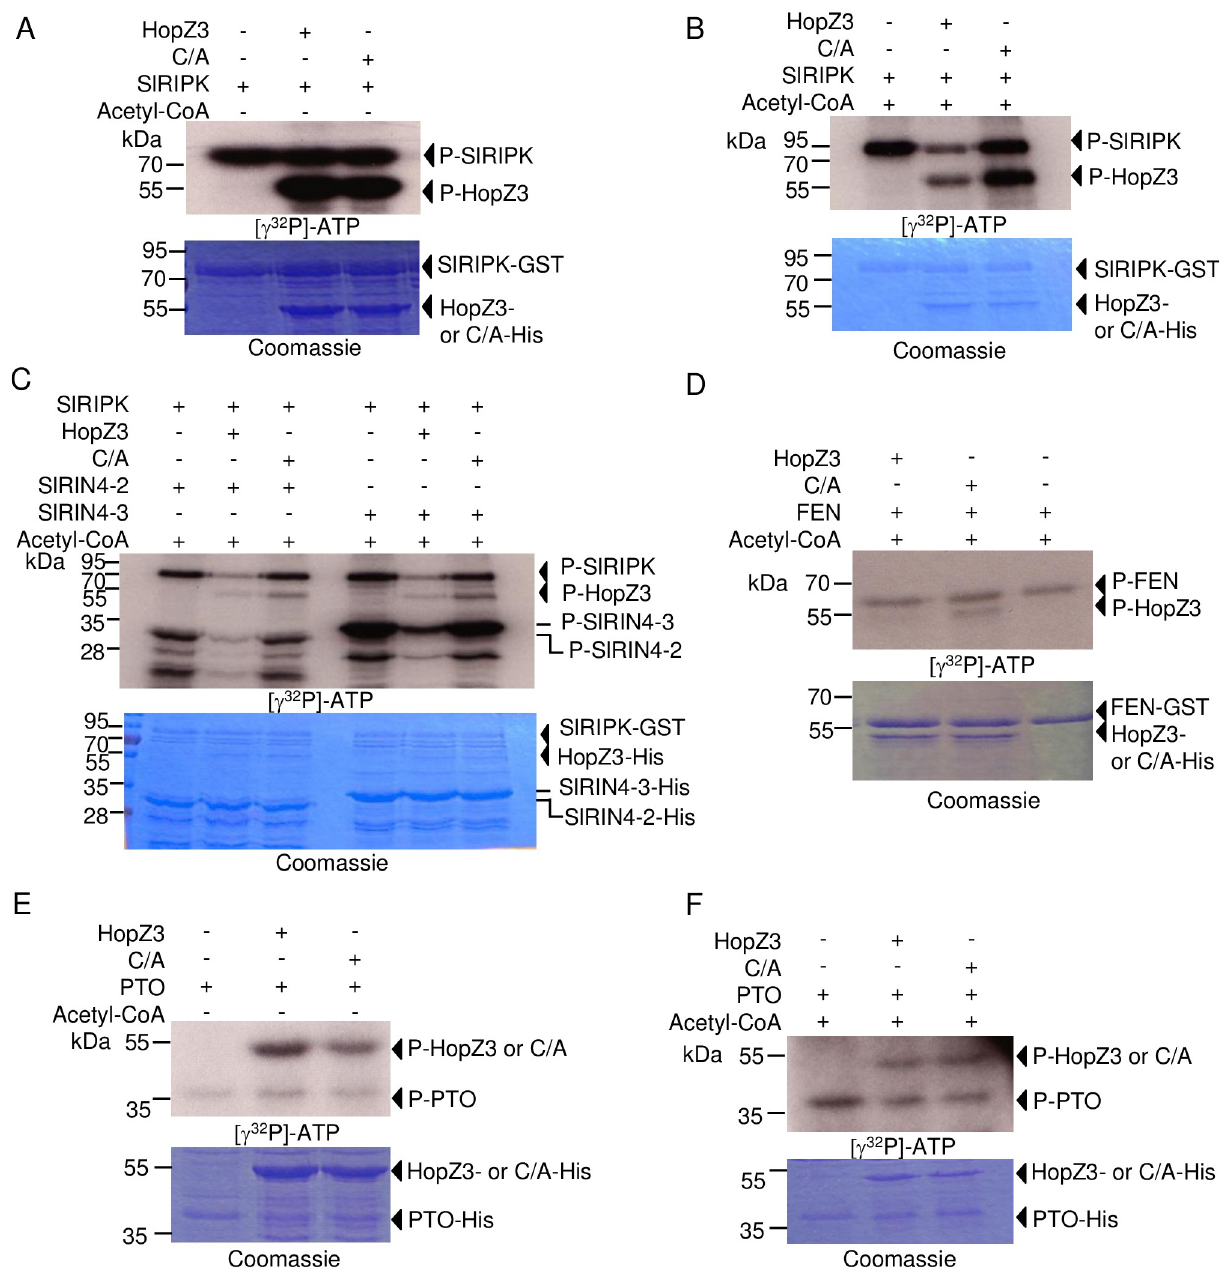
Fig 8. Differential effects of HopZ3 acetylation on kinase activity of RIPK, PTO and FEN. GST fusions of SlRIPK (A–C) and FEN (D) or PTO-His (E–F) were incubated with or without acetyl-CoA, IP6 and HopZ3 or HopZ3_C300A (C/A) for 2 h at RT and then washed with PBS buffer. After acetylation, the kinase activity of SlRIPK, FEN or PTO was initiated by adding γ 32 P-ATP and MgSO 4 for 30 min. at RT. (A) Incubation of SlRIPK with HopZ3 in the absence of Acetyl-CoA did not affect the kinase activity of RIPK. (B) After incubation with acetyl-CoA and HopZ3, RIPK-mediated phosphorylation of itself and HopZ3 was reduced. (C) Phosphorylation of SlRIN4s was reduced after acetylation of SlRIPK by HopZ3. (D) Incubation with acetyl-CoA, IP6 and HopZ3 did not affect the ability of FEN to phosphorylate itself. (E–F) Acetylation of PTO by HopZ3 did not affect PTO